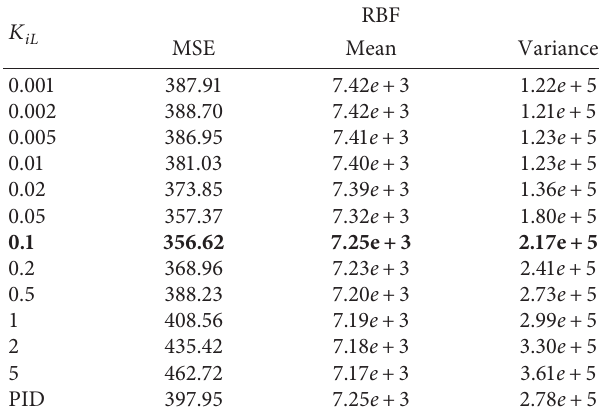
Table 9: Variation of MSE, output power mean, and variance with K iL .